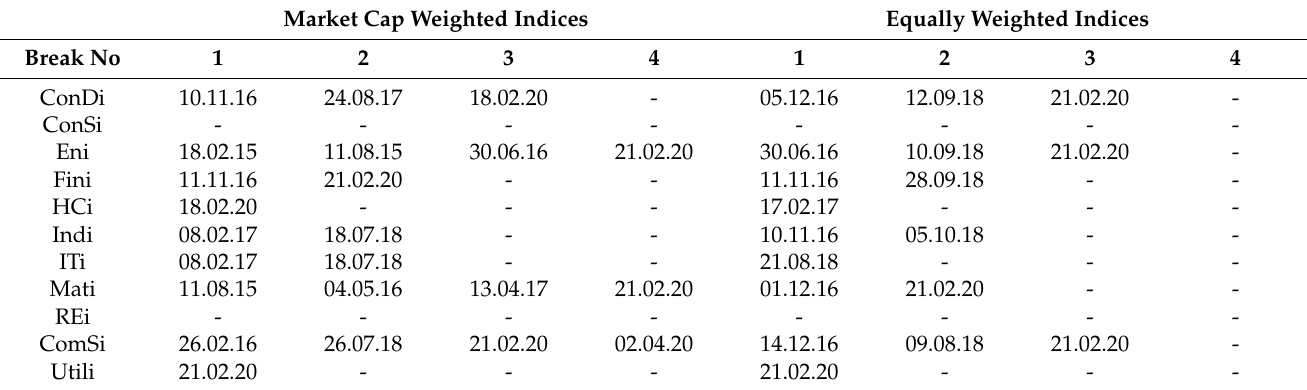
Table 4. Modified iterated cumulative sum of squares (M-ICSS) test